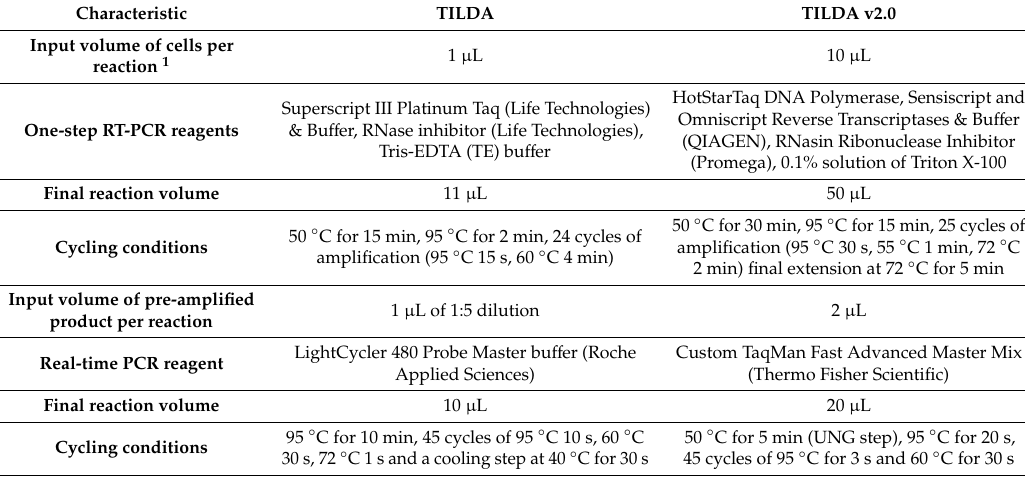
Table 1. Major di ff erences in RT-qPCR conditions in the two versions of TILDA.